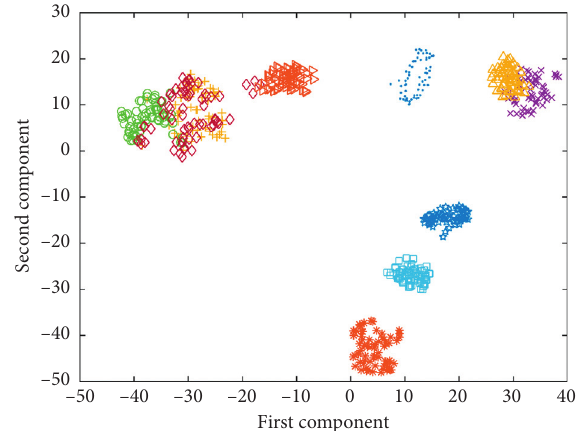
Figure 14: Visualization of 5% labeled sample.